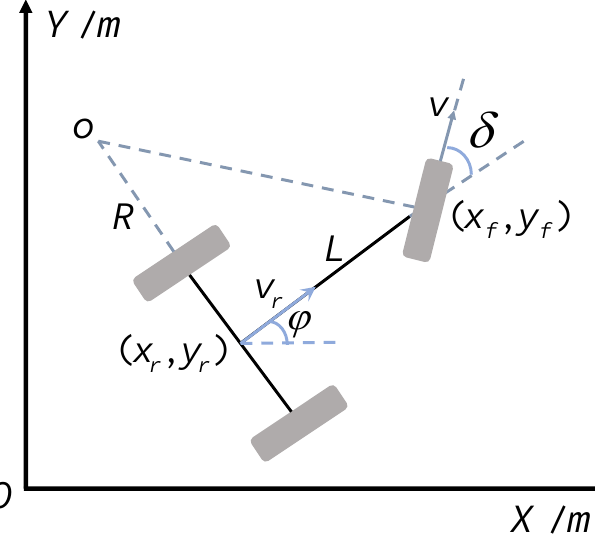
Figure 3. Kinematics model diagram of the forklift